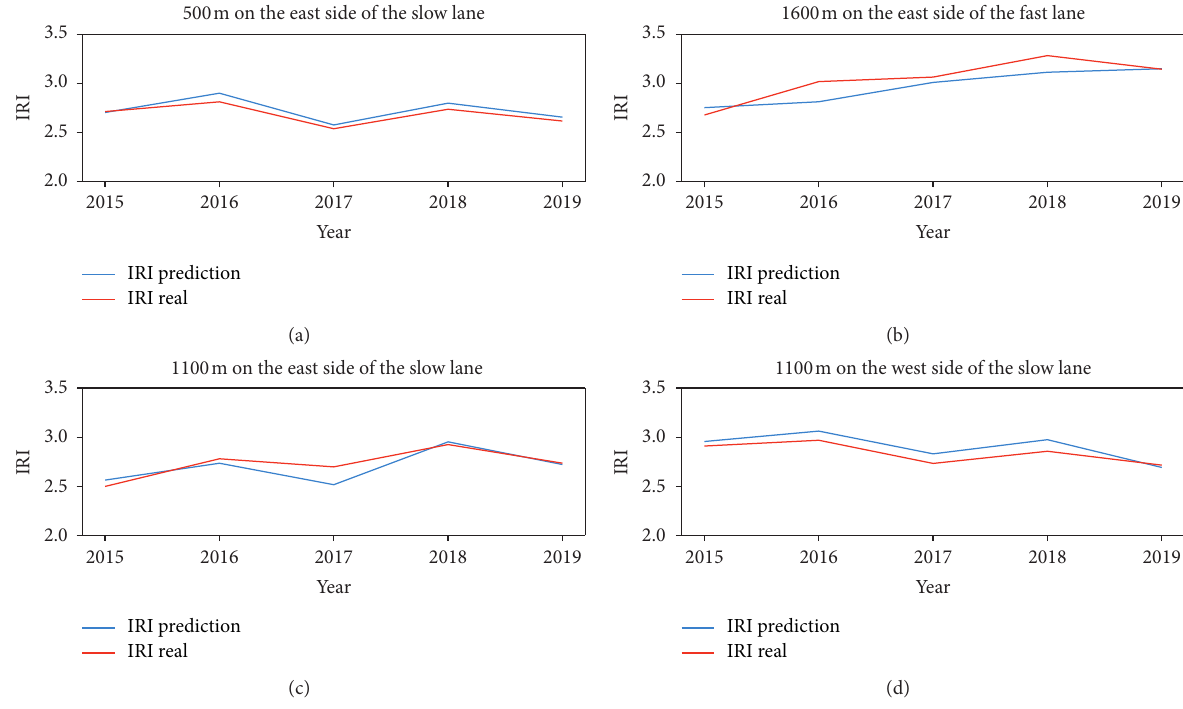
Figure 15: Segment prediction accuracy. (a) 500m on the east side of the slow lane. (b) 1600m on the east side of the fast lane. (c) 1100m on the west side of the slow lane. (d) 1100m on the west side of the slow lane.